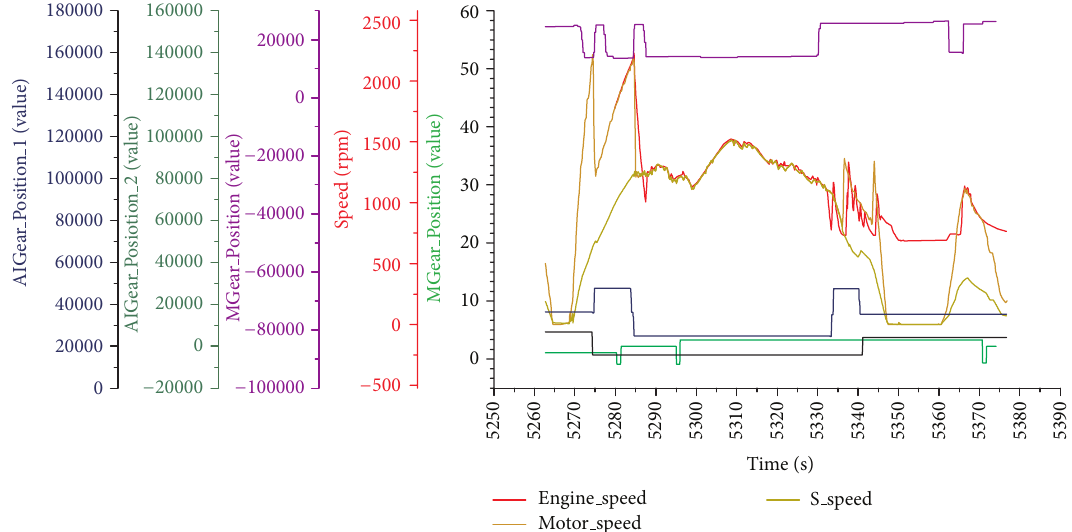
Figure 16: Road test curves of the gear